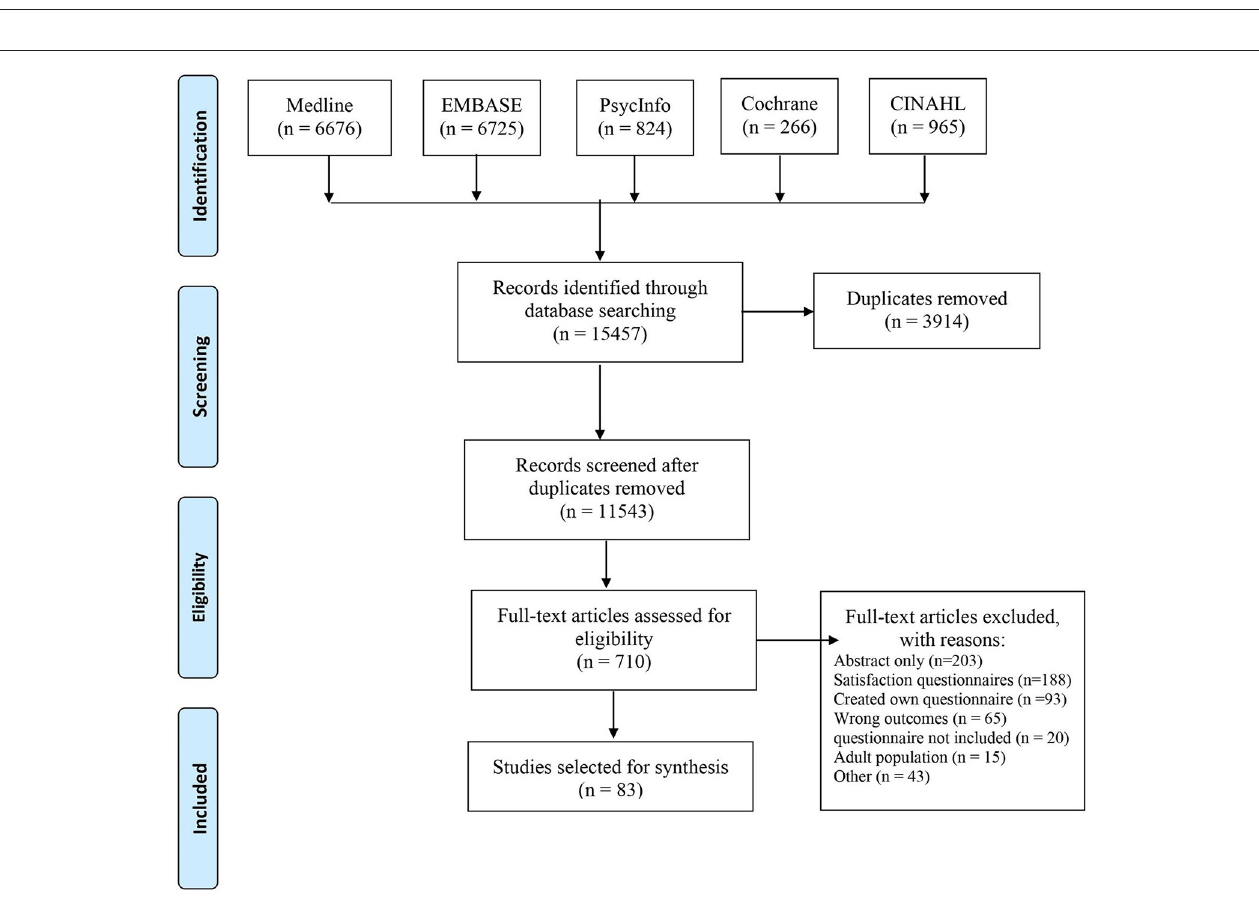
FIGURE 1 | Preferred Reporting Items for Systematic Review and Meta-Analysis (PRISMA) flow diagram of identification and selection process of